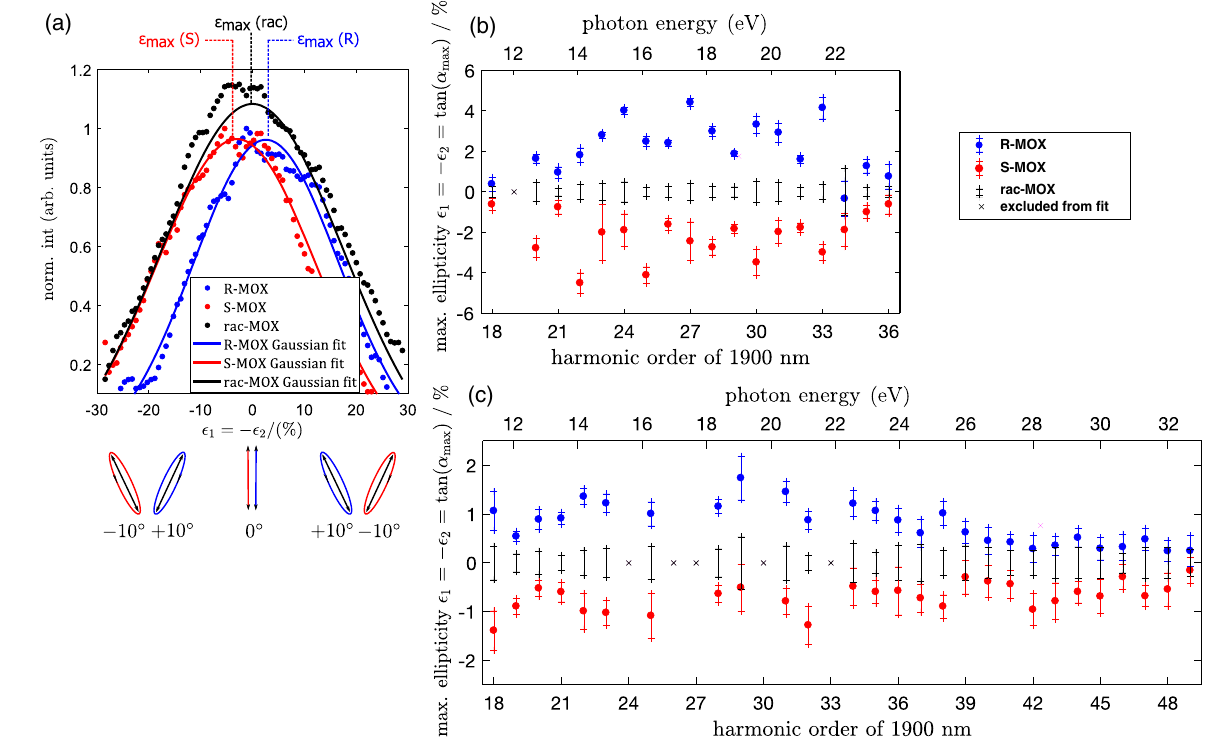
FIG. 4. Bielliptical high-harmonic spectroscopy. (a) HHG yield (data points) as a function of the driving ellipticity and Gaussian fits (full lines). The displacement of the maxima from α ¼ 0 is a signature of the chiral response. The Lissajous figures indicate the polarization ellipses of the two drivers. The black points and curve have been shifted vertically for better visibility. The displayed data correspond to H 28 of 1900 nm recorded at I ω ¼ 1 . 2 × 10 13 W = cm 2 and I 2 ω ¼ 1 . 8 × 10 13 W = cm 2 . (b),(c) Maximizing ellipticity ϵ as a function of the photon energy for two different intensities. (b) I ω ¼ 1 . 2 × 10 13 W = cm 2 , I 2 ω ¼ 1 . 8 × 10 13 W = cm 2 and max (c) I ω ¼ 1 . 5 × 10 13 W = cm 2 , I 2 ω ¼ 2 . 1 × 10 13 W = cm 2 . The error bars in (b) and (c) represent the 95% confidence interval obtained from the fitting